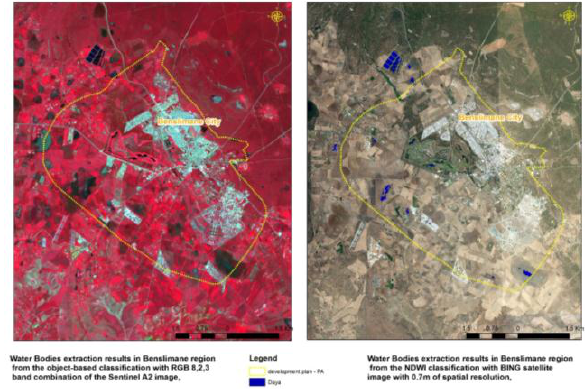
Figure 5. Identification of dayas by the NDWI index